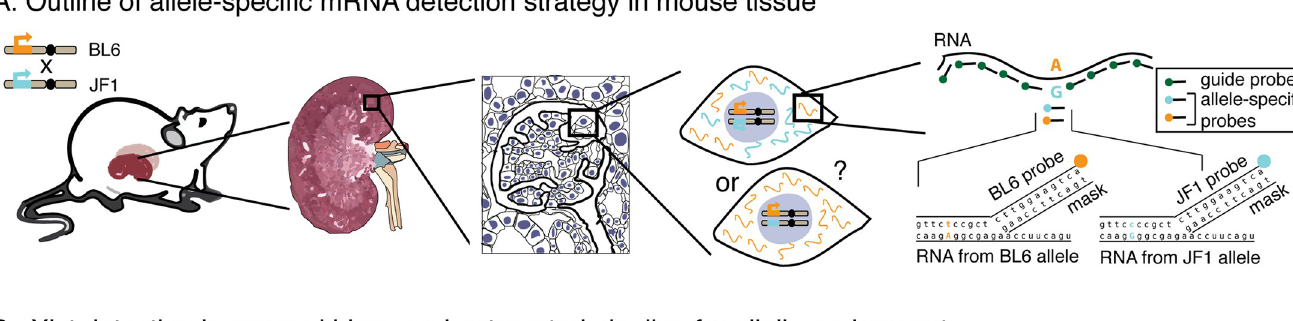
Fig 1. SNV FISH enables allele-specific detection of RNA in tissue. A. Collecting tissue from F1 heterozygous mice from crosses between BL6 and JF1 mice enabled allele-specific RNA detection in single-cells by utilizing a “toehold probe” strategy that targets polymorphisms between the two strains. While only a single polymorphism-probe is shown here for illustration, all genes were targeted with multiple SNV probes to increase the fluorescent signal. B. The pipeline for allele-specific detection of Xist foci in kidney tissue sections: First, whole-section tissue scans were used to collect fluorescence data in the guide and SNV channels (the scan shown is for the Xist guide probes labelled with Cal fluor 610). The guide probe signal was then used to automatically detect Xist foci, and the fluorescence intensity for the two allele-specific probes was extracted at the positions of those foci (BL6 was labelled with Cy3, JF1 labelled with Cy5). Clustering of the relative fluorescence intensities was applied to all foci, allowing automated allelic assignment for all spots across the entire tissue. C. Quantification of Xist allelic assignments in homozygous and heterozygous tissues. For each sample we depict the fraction of assigned BL6 and JF1 foci. For heterozygous samples biological replicates (ie tissue samples from different animals) are shown separately to reveal inter-individual variability in random X inactivation, while data from a technical replicate (two separate tissue sections from the same animal) is also plotted to show the effect of intra-individual variability and technical noise on allelic assignments. D. The pipeline for allele-specific detection of punctate mRNA spots in kidney tissue sections: whole tissue scans at 60x resolution in DAPI (staining nuclei) were used to obtain an overall impression of tissue morphology. Then, we collected z-stacks for randomly selected locations at 100x resolution in all channels of interest, which enabled detection of single cells and